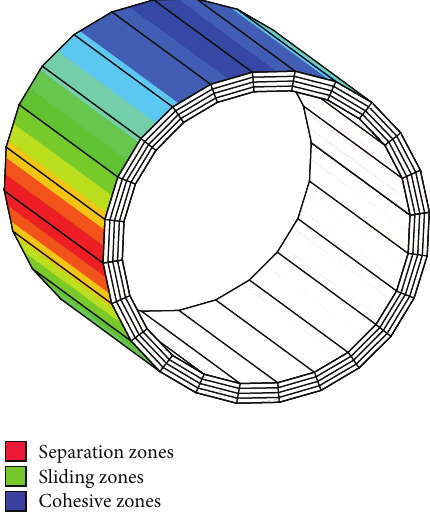
Figure 12: Failure modes of contact